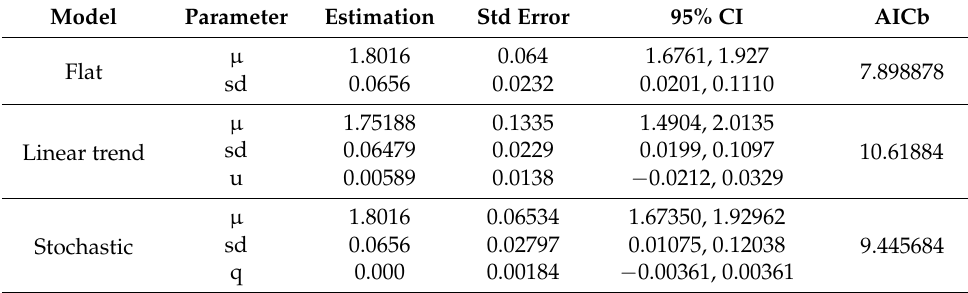
Table 1. Comparison of the three models for the hunting opportunity variable.